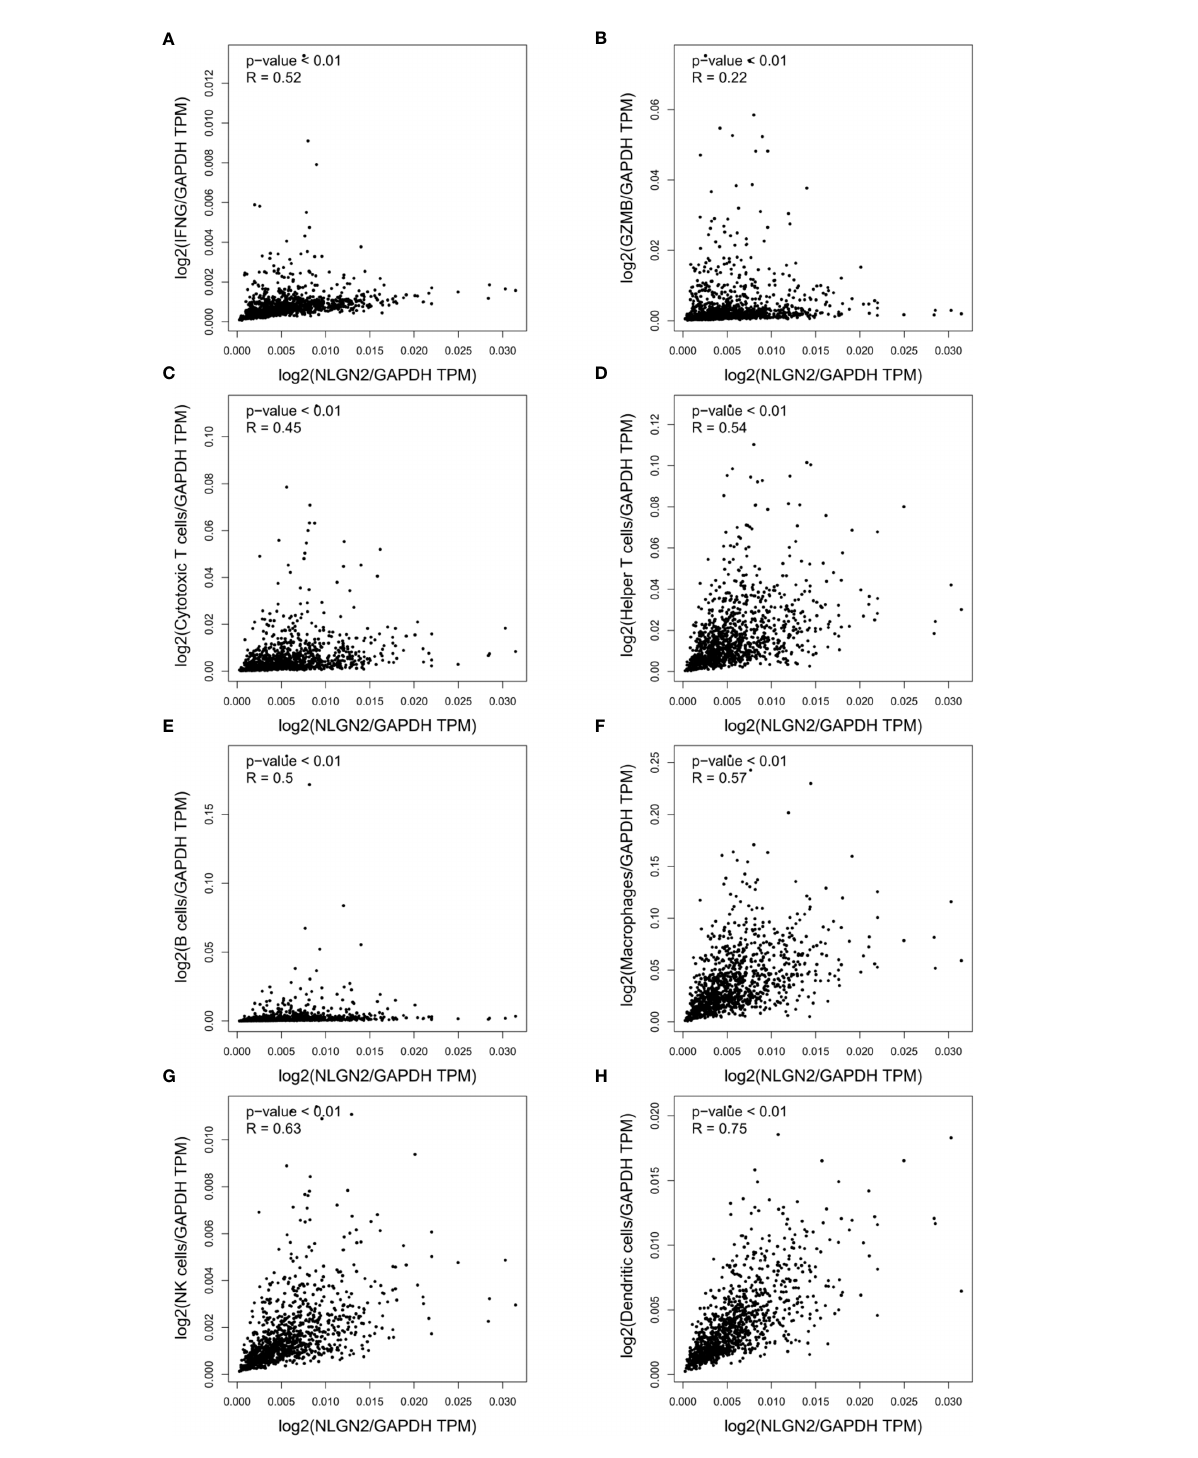
FIGURE 4 | NLGN2 correlates with immune signatures in breast tumor. (A) Correlation analysis of NLGN2 and IFNG in breast cancer (BRCA). (B) Correlation analysis of NLGN2 and GZMB in BRCA. (C) Correlation analysis of NLGN2 and Cytotoxic T cell signatures in BRCA. (D) Correlation analysis of NLGN2 and Helper T cell signatures in BRCA. (E) Correlation analysis of NLGN2 and B cell signatures in BRCA. (F) Correlation analysis of NLGN2 and Macrophage cell signatures in BRCA. (G) Correlation analysis of NLGN2 and NK cell signatures in BRCA. (H) Correlation analysis of NLGN2 and Dendritic cell signatures in BRCA. The p values and R coef fi cient are indicated in each panel, and p < 0.05 is statistically signi fi